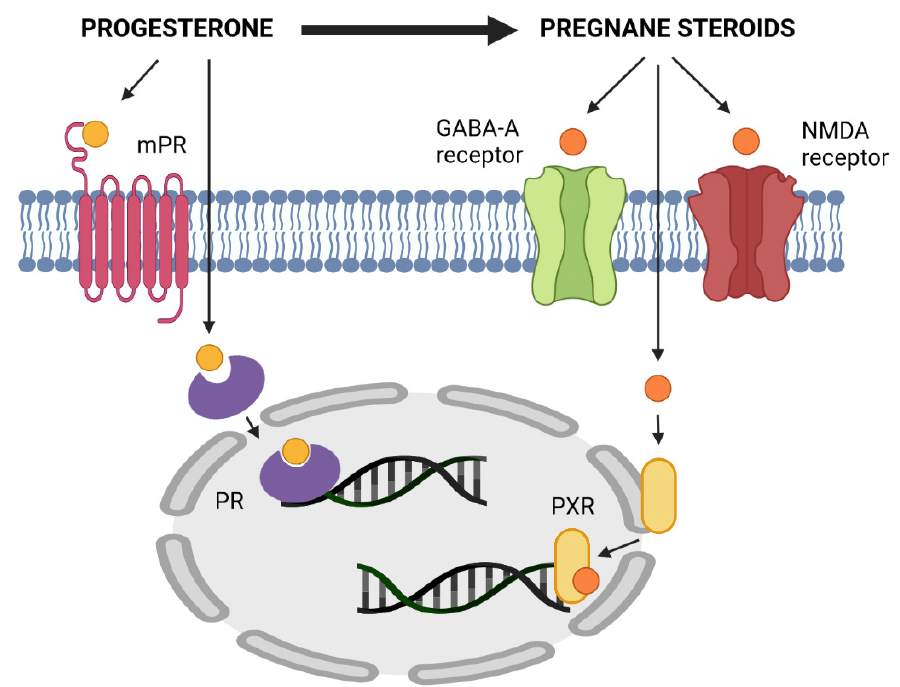
Figure 4. The action on progesterone and its neuroactive metabolites. PR — progesterone receptor, mPR — membrane progesterone receptor, PXR — pregnane X receptor. Created with